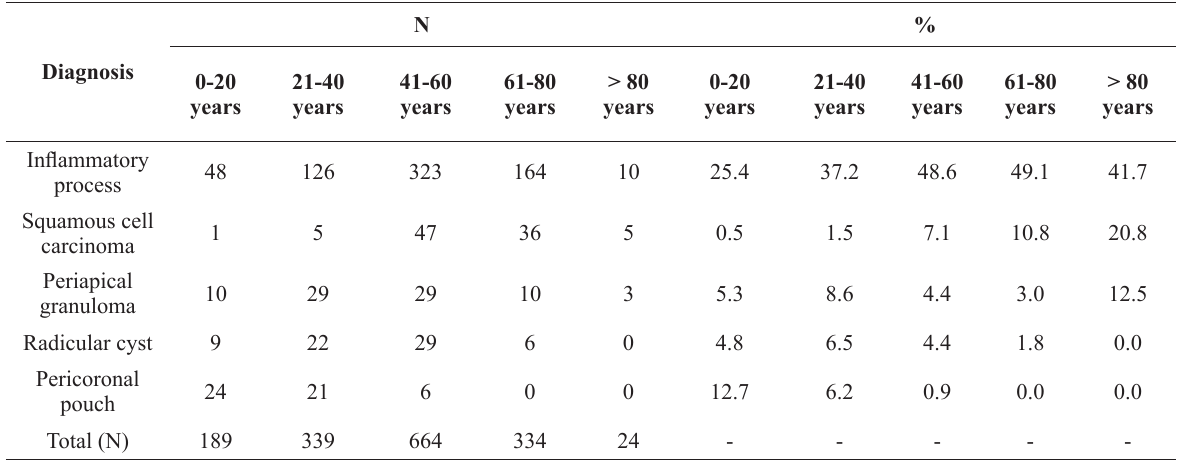
lesion diagnoses and